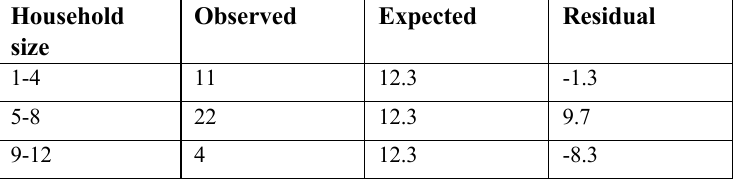
Table 1. Statistical Computation of Respondents’ Household